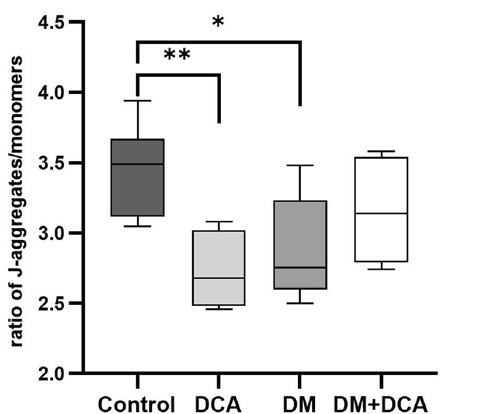
Figure 3. Effect of DCA treatment and experimental DM conditions on the mitochondrial membrane potential in the rat heart. Mitochondrial membrane potential was determined using the fluorescent probe JC-1 and expressed as the ratio of J-aggregates and monomers. The ratio of J-aggregates and monomers in the DCA group and DM group was significantly reduced compared with that in the Control group. Control—untreated control group; DCA—control group treated with dichloroacetate; DM—diabetic group; DM + DCA—diabetic group treated with dichloroacetate. Box plot graph displays minimum and maximum values and median shown by a horizontal line. n = 7 per DCA group, n = 8 per Control, DM, and DM + DCA group; *− p < 0.05, **− p < 0.01. Control versus DCA ( p = 0.0030), Control versus DM ( p =